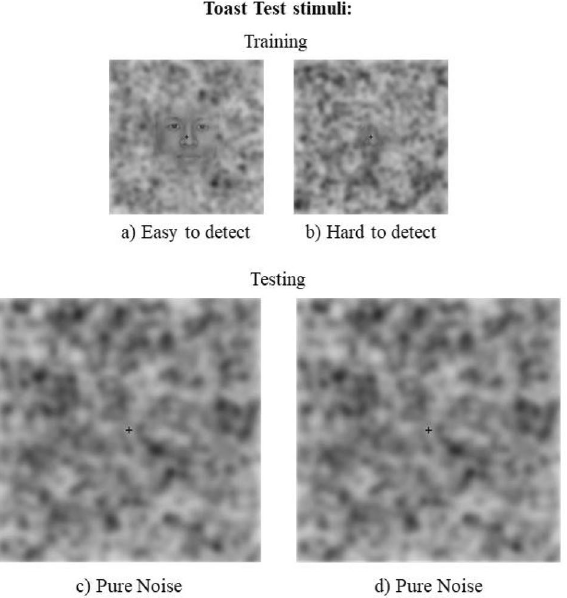
Figure 3. Sample stimuli in the Toast test. ‘Easy to detect’ ( a ) and ‘hard to detect’ ( b ) sample stimuli from the training phase; ‘pure noise’ ( c , d ) sample stimuli from the testing phase 1